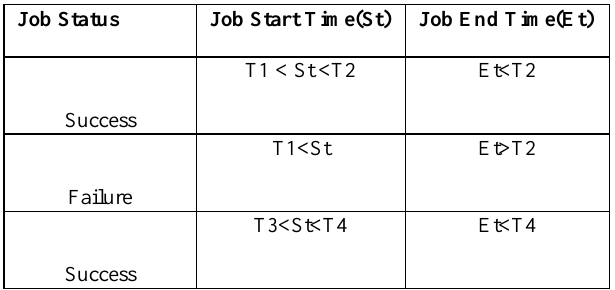
Table 1. Relationship between Job status and Resource Life